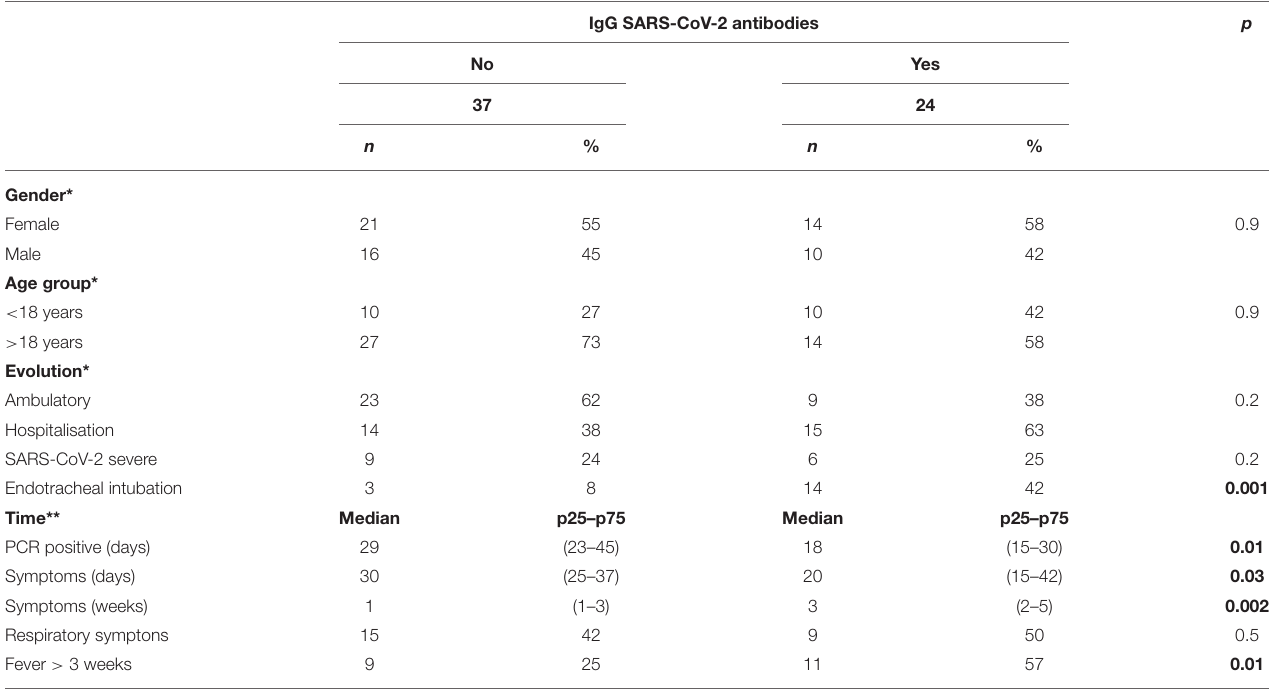
TABLE 1 | Differences between patients with and without IgG antibodies to SARS-CoV-2.